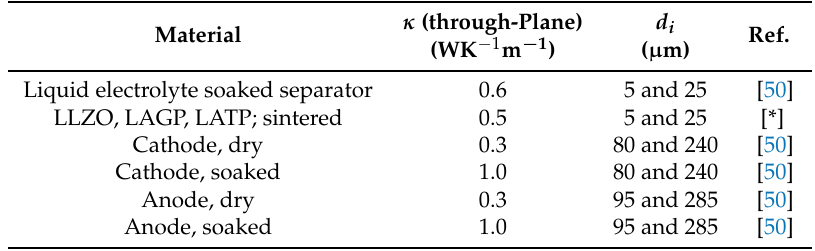
Table 2. Thermal conductivities used in the model shown in Equation (9).